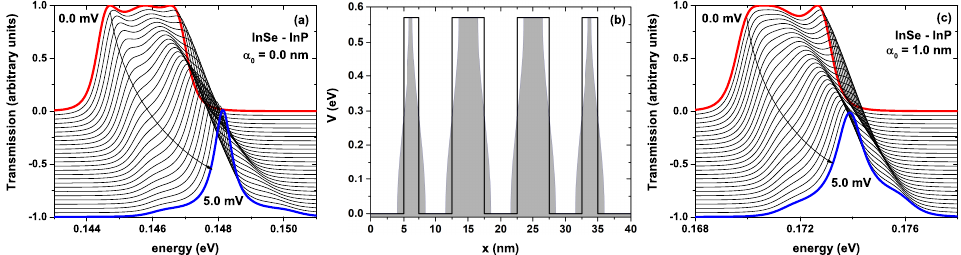
Figure 8. In ( a ), the transmission probability for the InSe-InP lattice without laser effect for different bias voltages concerning the incident electron energy; ( b ) the scheme of the potential profile for the barrier-well lattice system; the black curve corresponds to the system without laser effect and the shaded region including an ILF parameter strength of α 0 = 1.0nm; ( c ) the same as in ( a ), but with an ILF effect, α 0 = 1.0nm. The width of the wells and the two central barriers have been set at 5nm and the two lateral barriers at